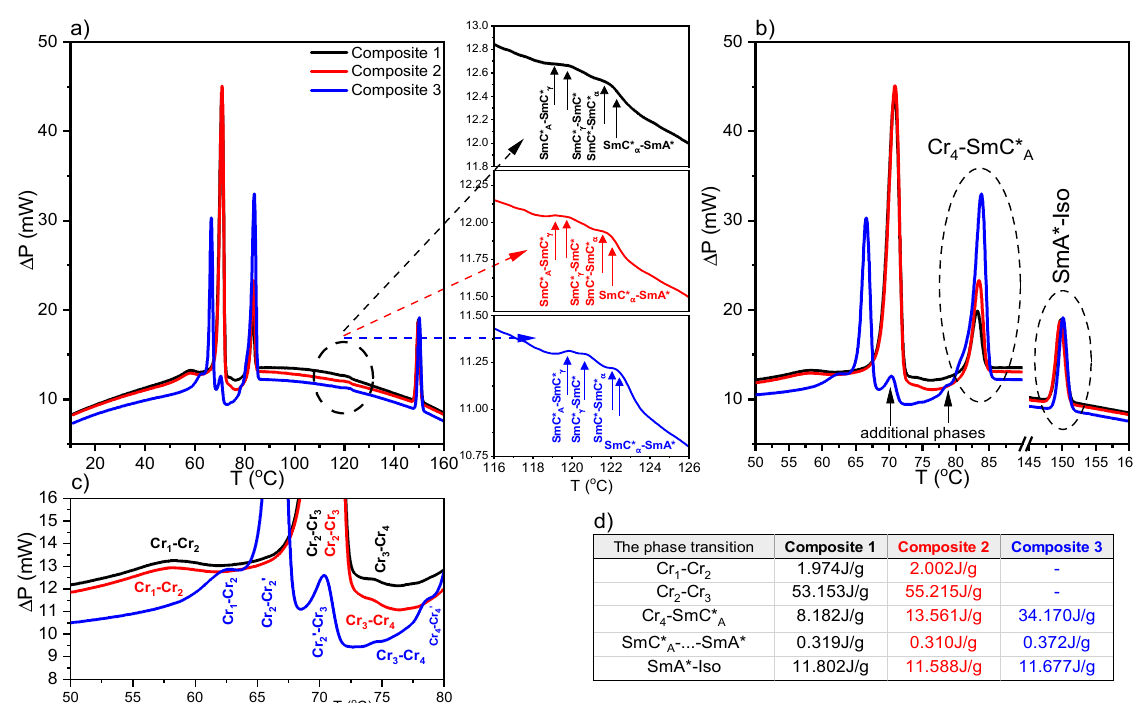
Figure 2. Calorimetric curves registered during heating for Composites 1–3 ( a ). Insets in ( a ) represent an enlarged temperature range of 116–126 °C for individual Composites. Enlarged temperature range of the DSC curves registered for Composites 1–3 with additional phase transition for Composite 3 marked by a vertical arrow ( b ), DSC curves at low temperature range ( c ), and table with the enthalpy changes for the chosen phase transitions ( d ).